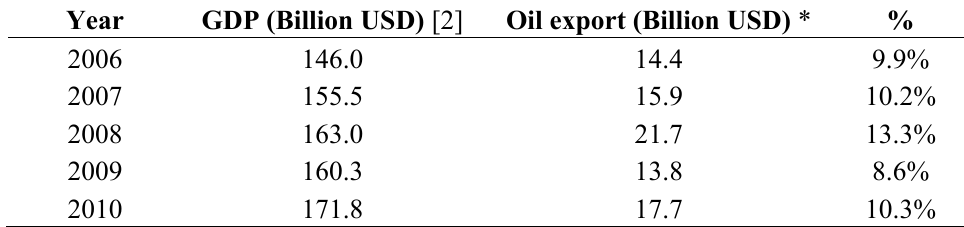
Table 1. Oil export value in